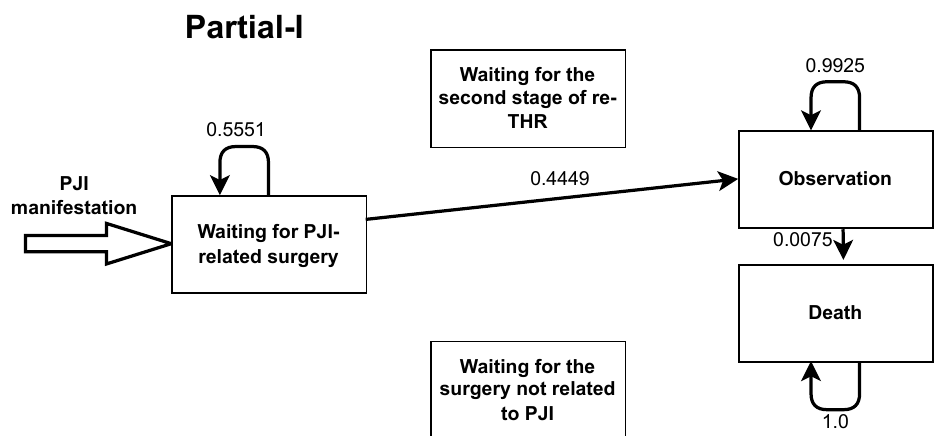
Figure A7. Markov model transition probabilities for partial one-stage total hip replacement.